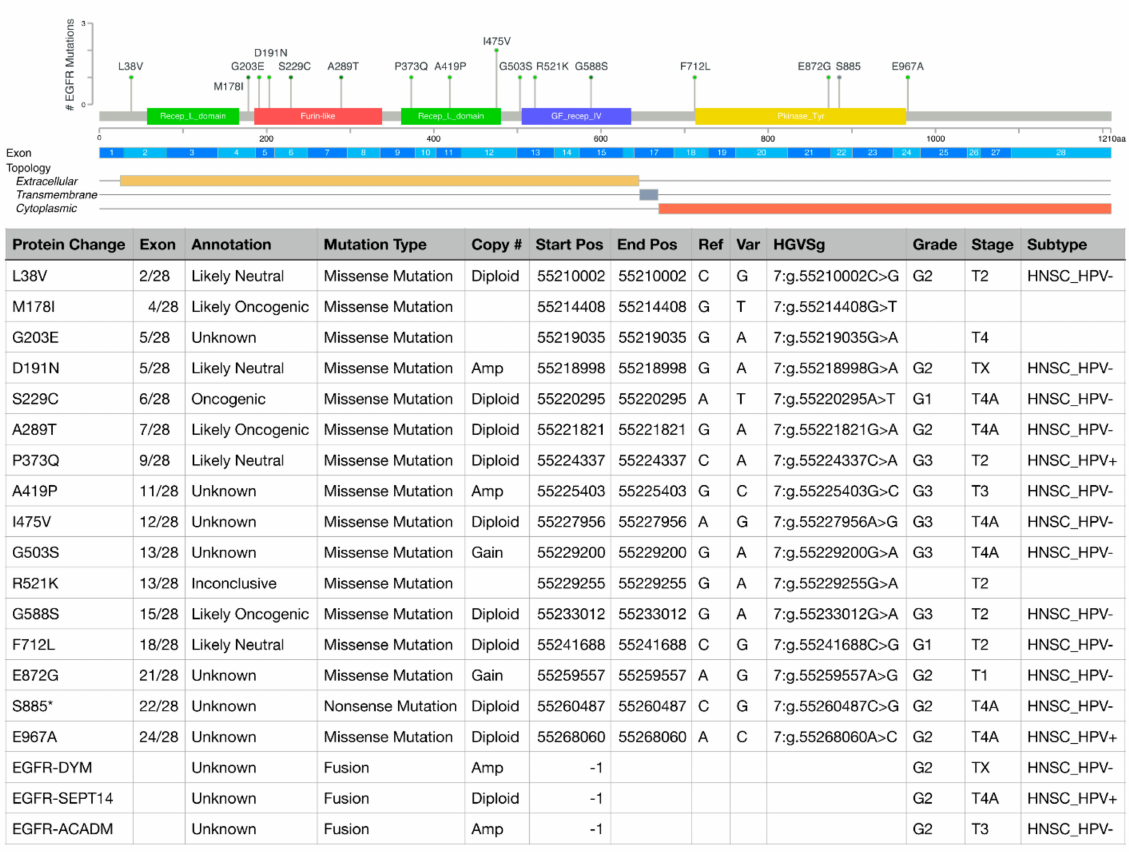
Figure 2. EGFR mutations and gene fusions in HNSCC patients curated in the cBioPortal for Cancer Genomics in relation to EGFR exons and EGFR protein domains. The table shows details of the specific mutations and corresponding patients, including protein change, exon location, functional annotation according to OncoKB precision oncology knowledge base, type of mutation, EGFR gene copy number, mutation site, nucleotide change (reference [Ref] vs. variant [V]), Human Genome Variation Society genomic nomenclature (HGVSg), tumor grade, tumor, stage, HPV subtype (+, positive; − ,